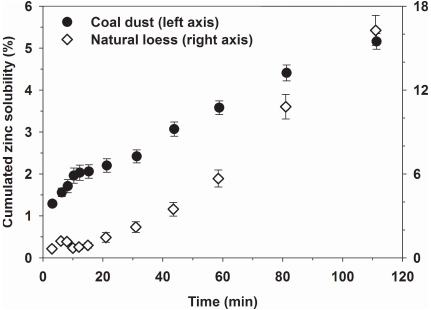
Fig. 6. Cumulated solubility of zinc (%) for anthropogenic and nat- ural dust as a function of time.